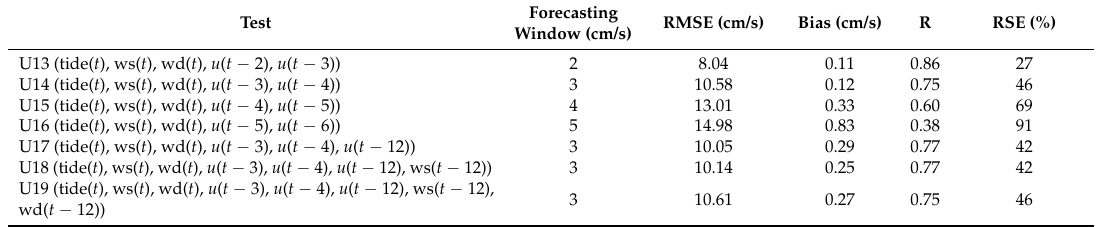
Table 8. Averaged statistics of u velocity component at ten locations (testing dataset). Test